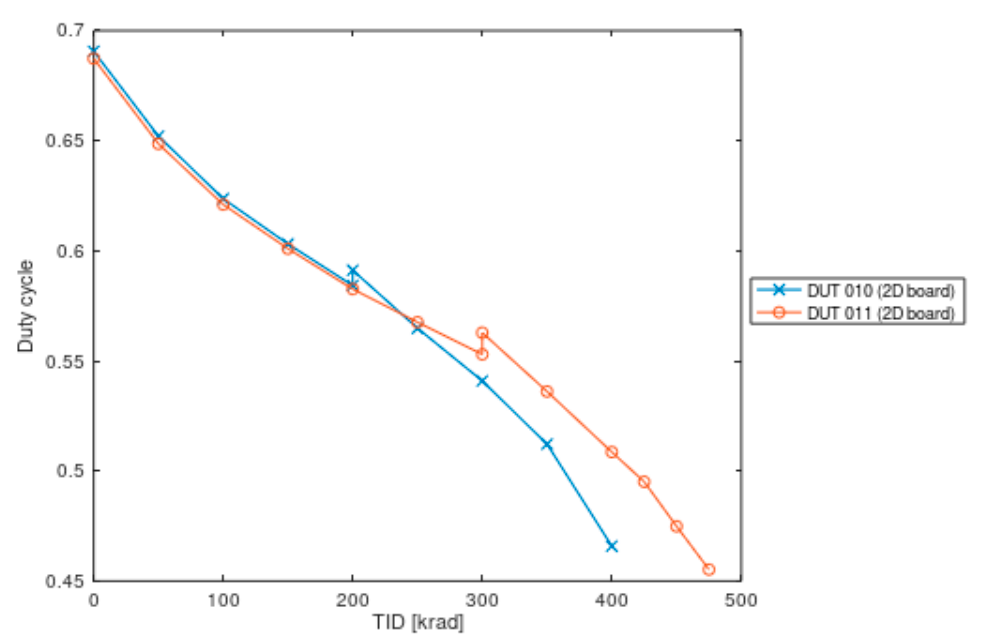
Figure 8. PoL 2D board MOSFET driver duty cycle change as a function of the total ionizing dose (X-ray irradiation).